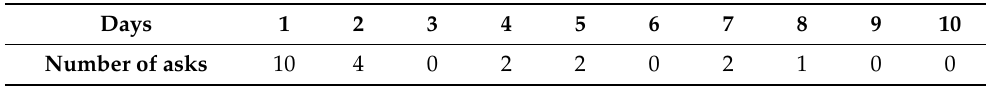
Table 6. Number of asks each